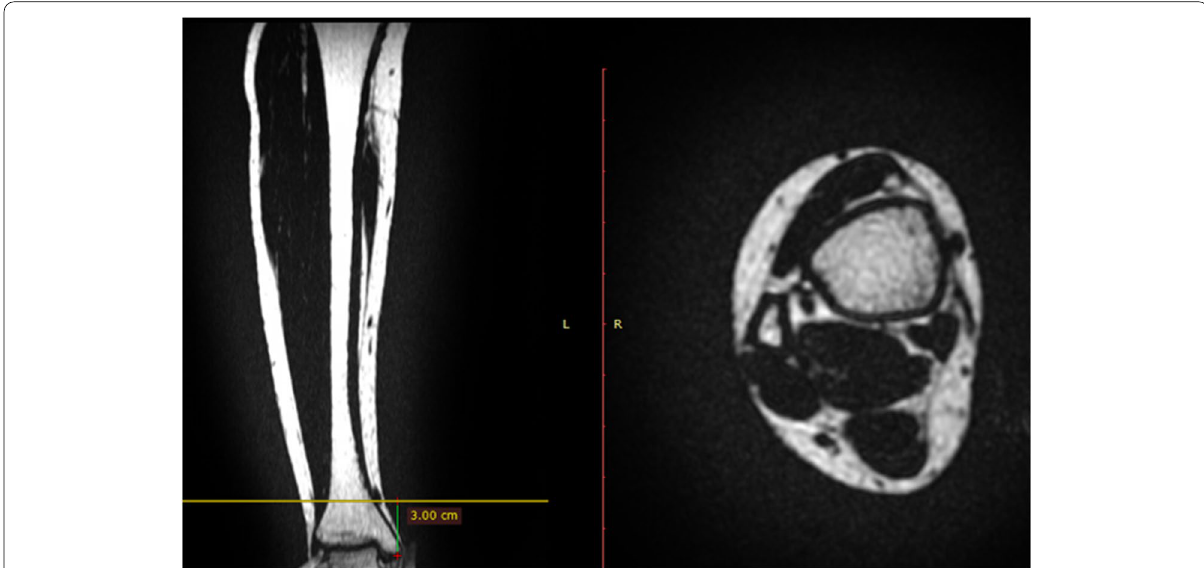
Fig. 1 Fat-only images using LAVA-flex in a 22-year-old woman. Left: Coronal plane image reconfigured from transverse images. The vertical line from the medial malleolus was drawn by the author. The transverse line in the coronal plane image was drawn based on the selected transverse plane. Right: Transverse plane image at 3 cm from the medial malleolus. Transverse plane images were obtained during the experimental